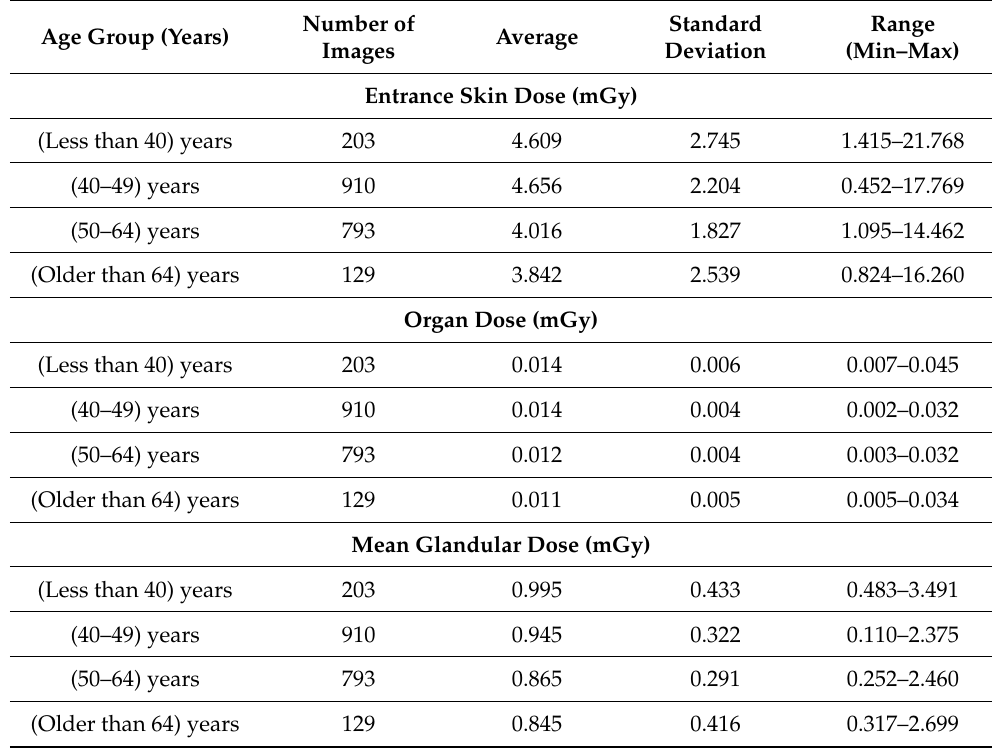
Table 3. Descriptive summary of entrance skin dose (ESD), organ dose (OD), and mean glandular dose (MGD) based on age group.